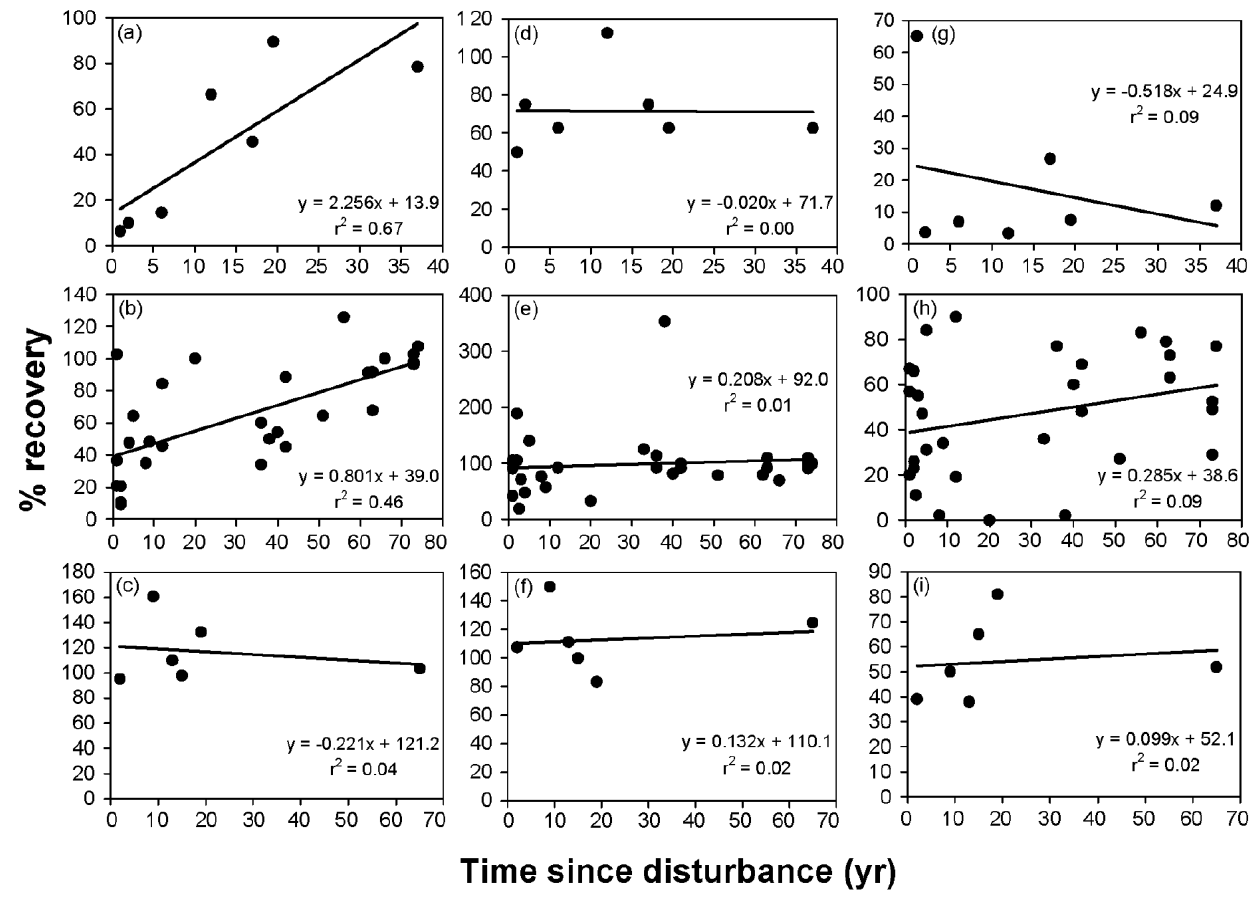
Figure 3. Examples of studies that examined time since disturbance (TSD) relationships with variables of plant recovery in the Mojave and Sonoran Deserts of the American Southwest. Plant cover and richness are expressed as the percent of levels found on undisturbed areas ([disturbed/undisturbed] × 100). (a) Perennial plant cover [51]. (b) Perennial plant cover using data from 29 individual studies that each made one TSD measurement. (c) Annual plant cover [67]. (d) Perennial species richness [51]. (e) Perennial species richness using data from 30 individual studies that each made one TSD measurement. (f) Annual plant richness [67]. (g) Disturbed:undisturbed similarity of perennial species composition [51]. (h) Disturbed:undisturbed similarity of perennial species composition using data from 31 individual studies that each made one TSD measurement. (i) Disturbed:undisturbed similarity of annual species composition